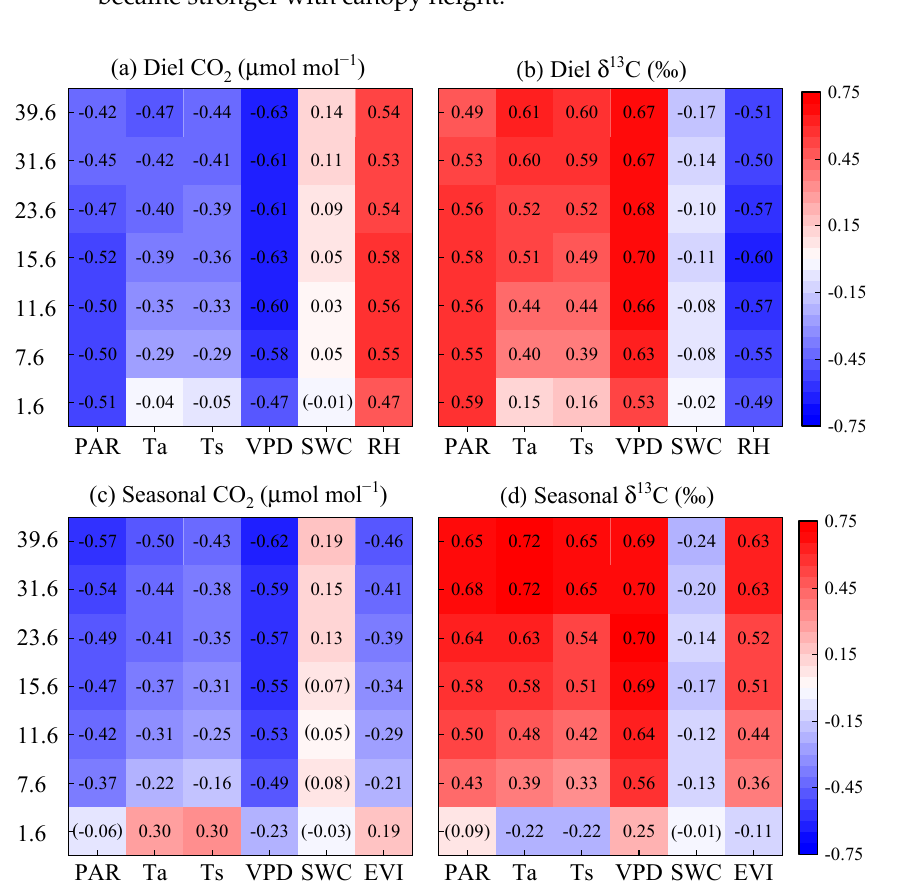
Figure 7. Correlation matrix of daily CO 2 and its δ 13 C at different canopy layers with half hourly ( a , b ) and daily ( c , d ) environmental and biological factors between 2015 and 2017. Pearson correlation coefficients in brackets are not significant ( p > 0.001).